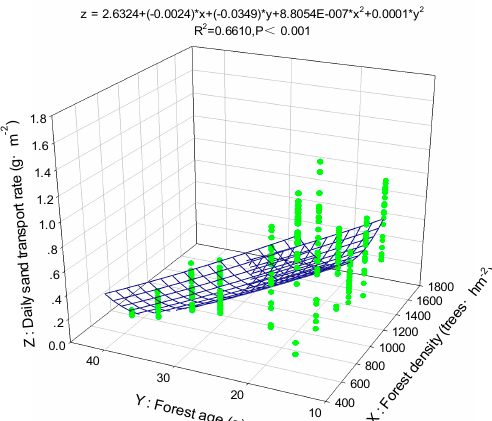
Figure 14. Relationship between poplar density, age, and daily sand transport rate in Zhangbei County, Hebei Province, China. Table 2. Daily sand transport rates under the different poplar stand densities and age combinations in Zhangbei County, Hebei Province, China.